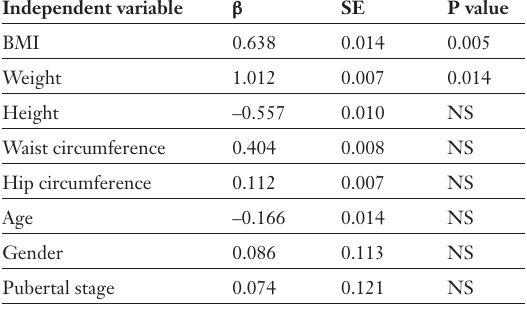
Multivariate regres- sion analysis be- tween HOMA index as dependent vari- able and plasma vis- fatin concentration, body mass index and waist circumference as independent